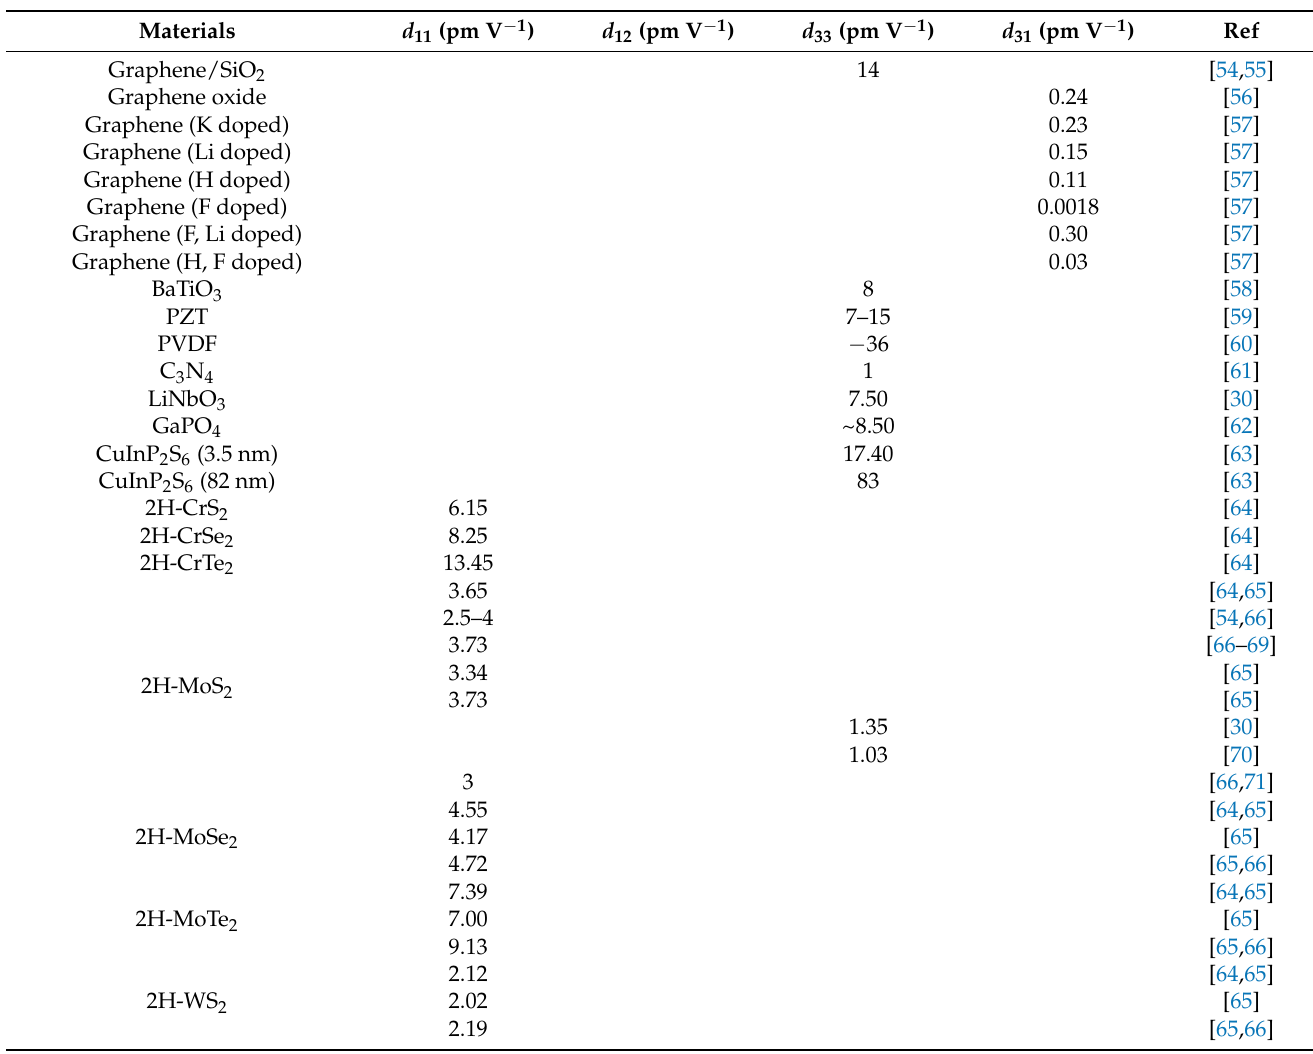
Table 1. Piezoelectric coefficient of common piezoelectric materials (pm V − 1